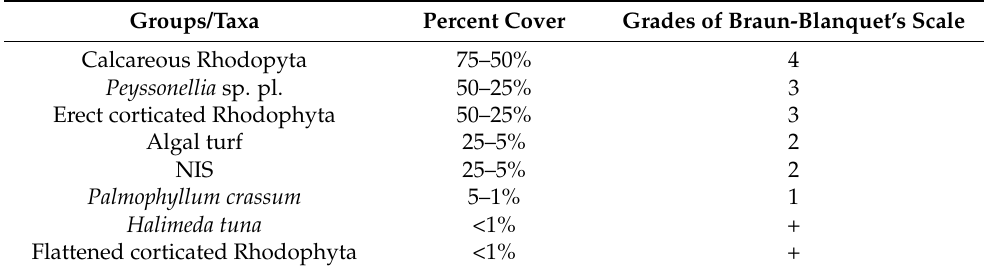
Table 3. Percent cover (and corresponding degrees of the Braun-Blanquet’s scale) of the main morphological groups/taxa characterizing the coralligenous assemblage of the